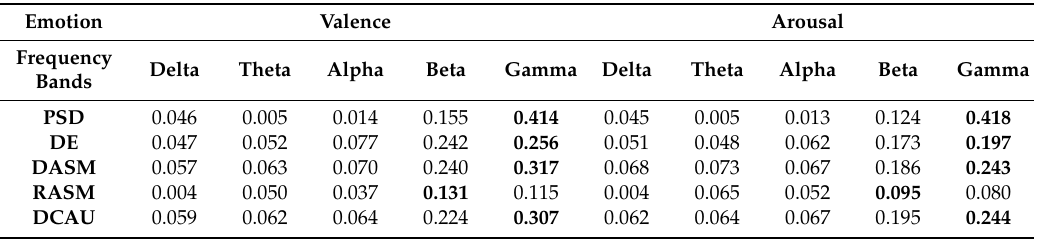
Table 4. Fisher ratio of di ff erent frequency bands by averaging the values over all features and subjects in valence and arousal dimensions,